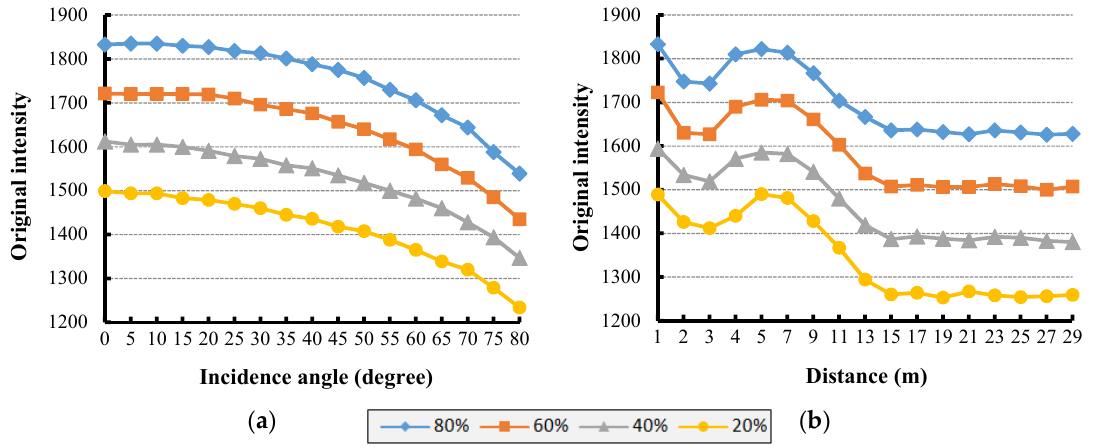
Figure 4. ( a ) Original intensity with respect to incidence angle at a distance of 5 m for the four reference targets; ( b ) Original intensity with respect to distance at an incidence angle of 0° for the four reference targets.